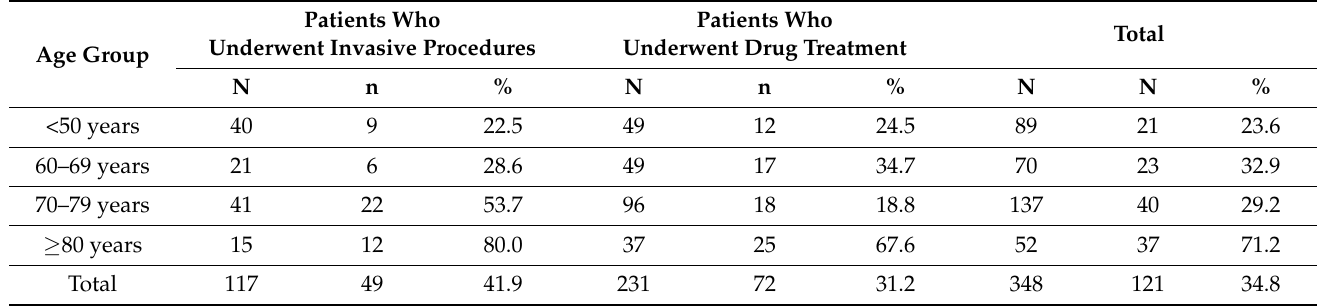
Table 1. Distribution of patients by age group before and after the exclusion